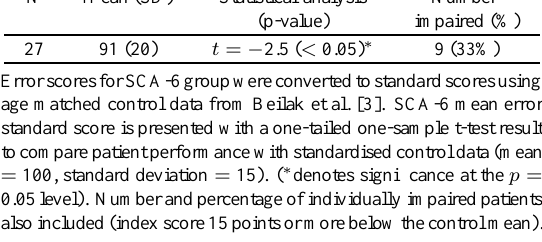
Table 6 Spearman’s rho correlations (one-tailed) between WMS-III index scores, severity of motor impairment and disease